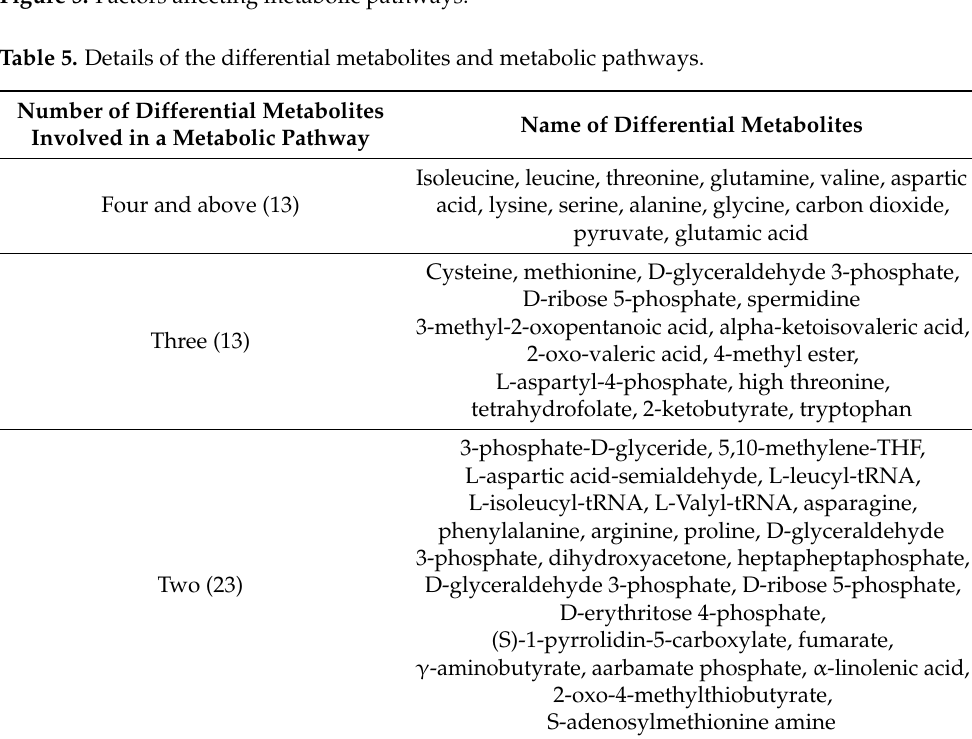
Table 5. Details of the differential metabolites and metabolic pathways.